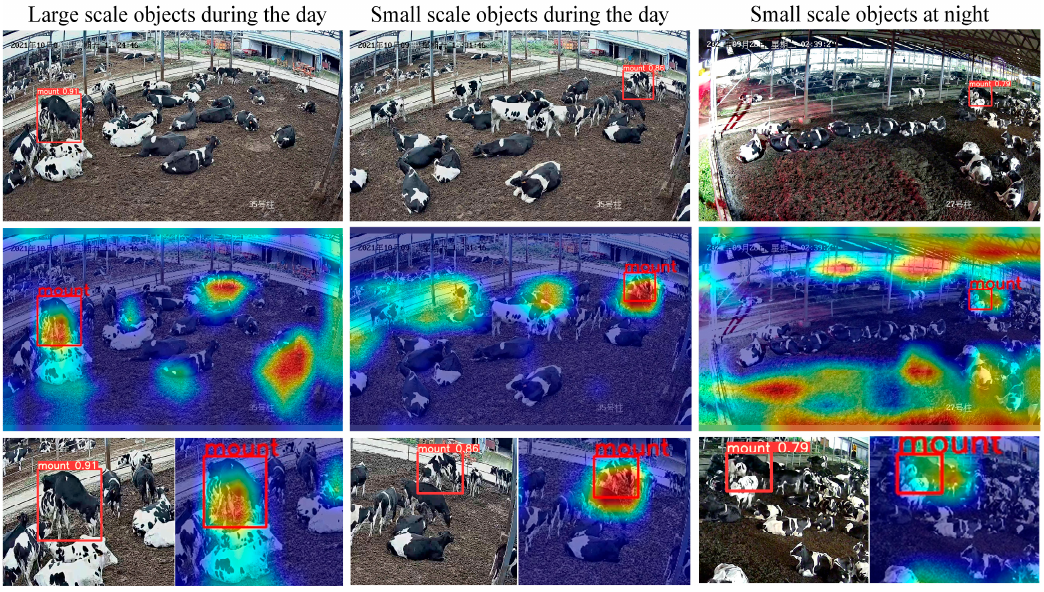
Figure 11. Visualization analysis of cow mounting behavior extracted by CEBD-YOLO.